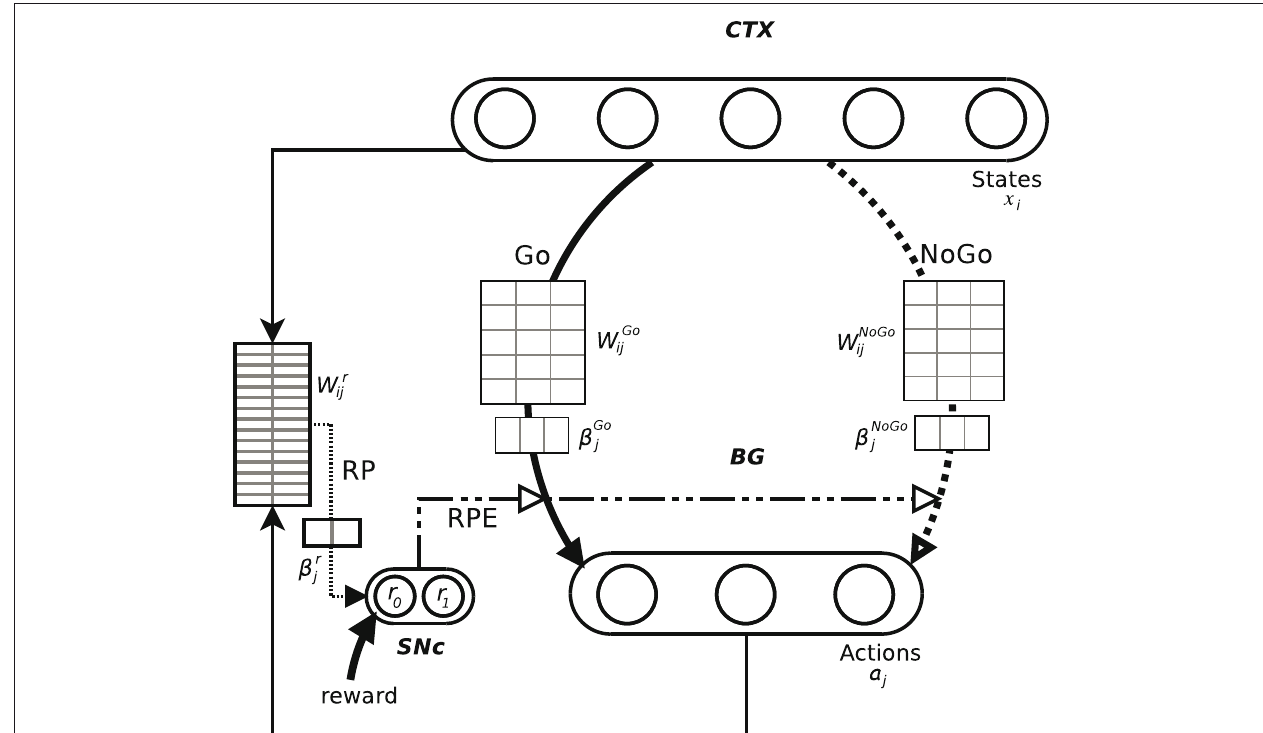
FIGURE 2 | Schematic representation of the model and its pathways. The output layer should be seen as the whole basal ganglia. The Go and NoGo connections are all to all from the input layer, here with 5 states, to the output layer, here with 3 actions. The information about the current state and